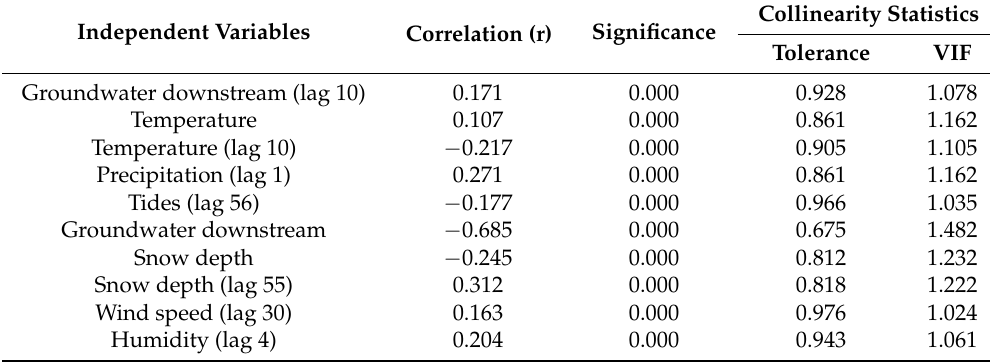
Table 4. The correlation (r) values are reported for the seasonal-term component between the water discharge and the predictor variables. The second column describes the significance level for each predictor variable derived from the time series regression (TSR) model, the third column the collinearity tolerance, and the fourth column describes the variance inflation factor (VIF). The lag values are indicated within the